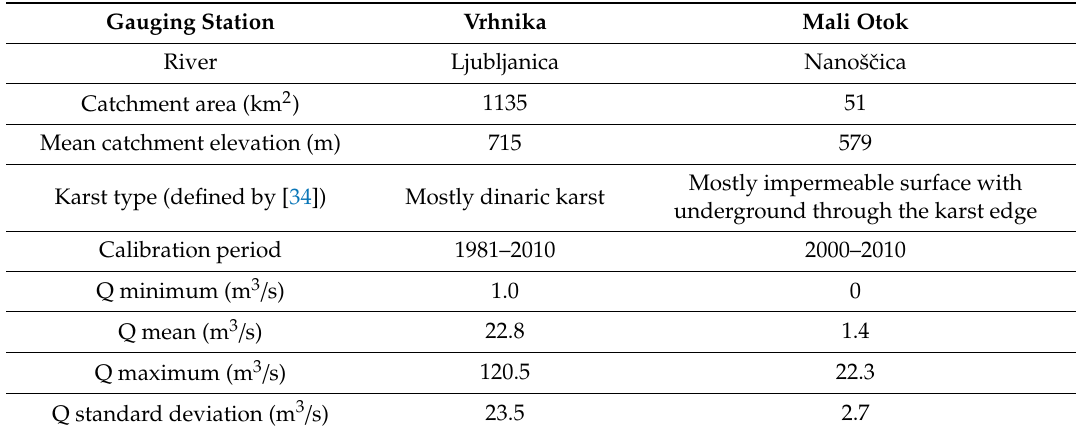
Table 1. Basic characteristics of the selected case studies and basic characteristics of the discharge series (Q) that were used for the model calibration.